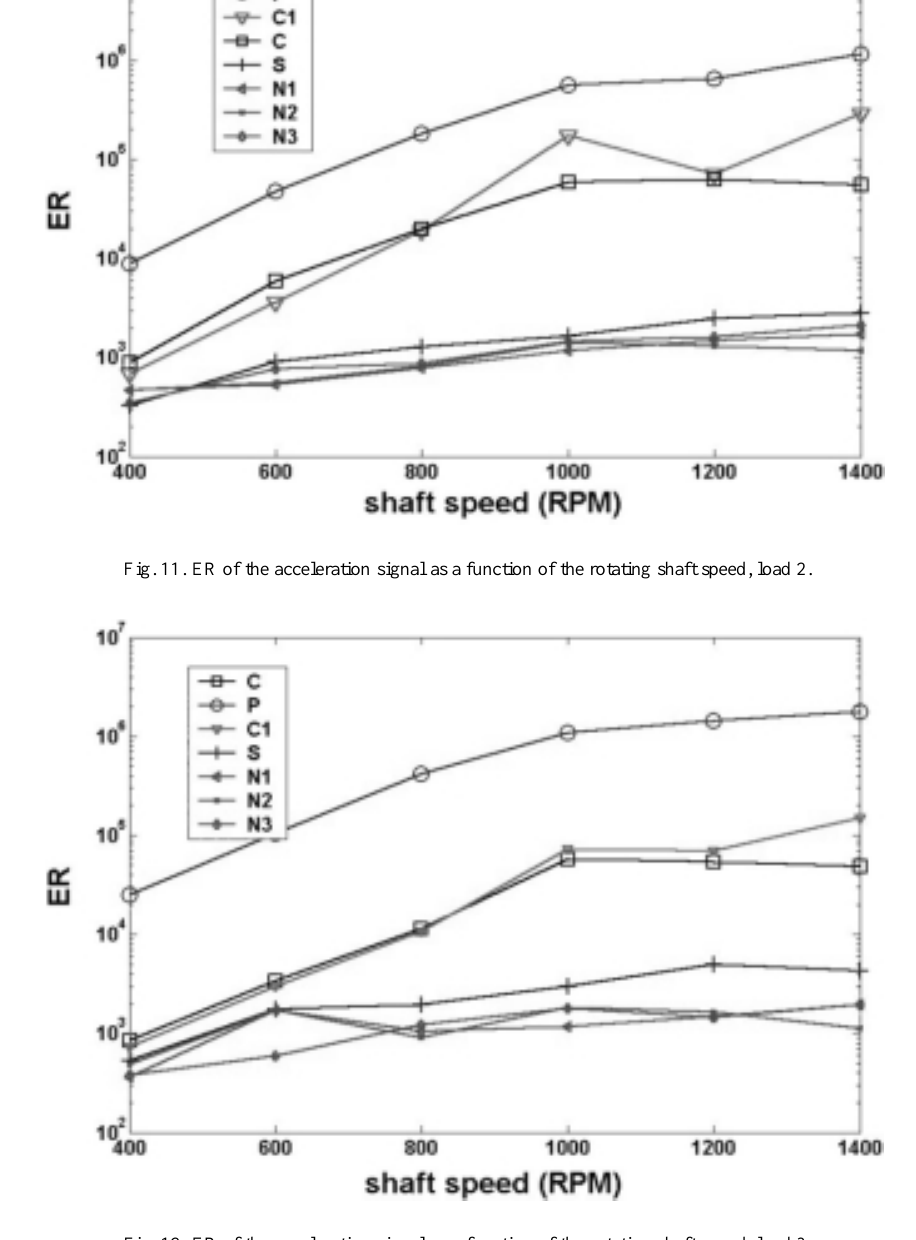
Fig. 12. ER of the acceleration signal as a function of the rotating shaft speed, load